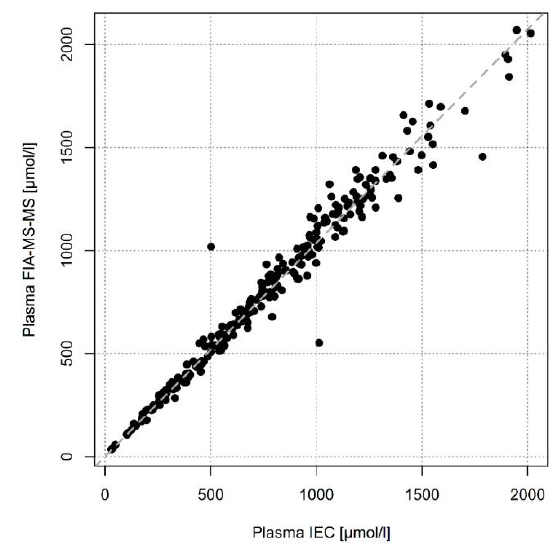
Figure 1. Regression of plasma Phe measured by FIA-MS-MS on plasma Phe measured by IEC (n =